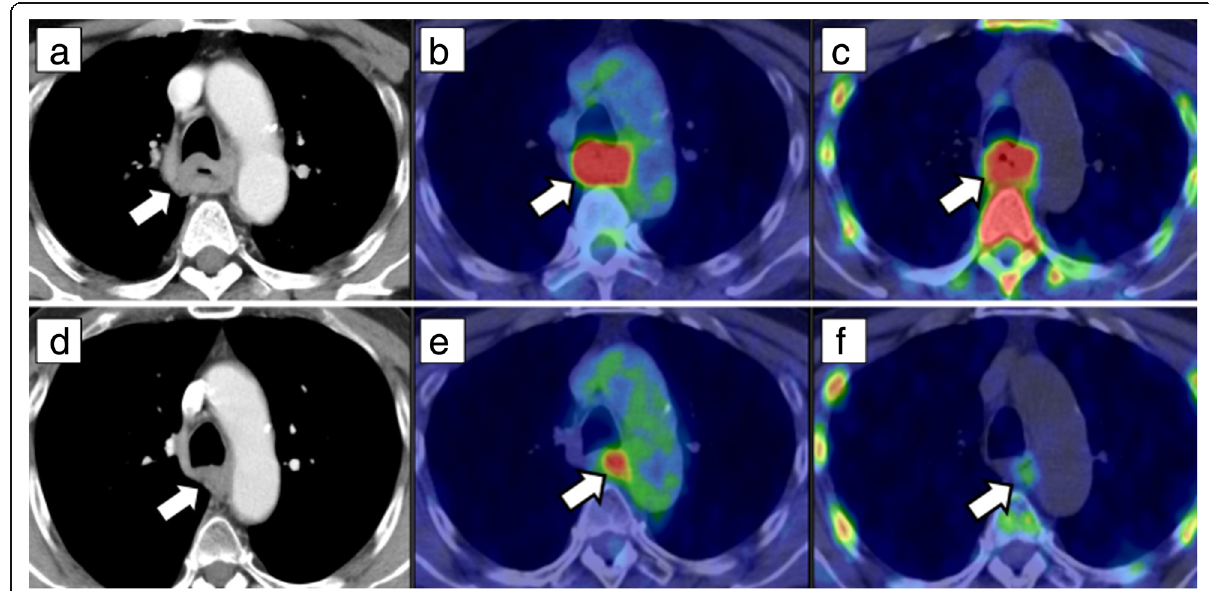
Fig. 3 A 68-year-old man with esophageal cancer treated by neoadjuvant chemoradiation therapy followed by esophagectomy. Baseline images (CT ( a ), FDG-PET/CT ( b ), and 4DST-PET/CT ( c )). Post-neoadjuvant therapy images (CT ( d ), FDG-PET/CT ( e ), and 4DST-PET/CT ( f )). Baseline chest CT showed esophageal cancer ( a : arrow) in the upper thoracic region, and FDG and 4DST PET/CT demonstrated uptake into the primary lesion ( b , c : arrow). Maximum standardized uptake value (SUVmax) of FDG and 4DST was 13.5 and 6.2, respectively. After neoadjuvant chemoradiation therapy, the tumor showed reduction in size ( d : arrow). Post-therapeutic FDG-PET/CT demonstrated FDG-avid (SUVmax = 5.3) primary lesion ( e : arrow) suggesting the possibility of inadequate response. In contrast, 4DST-PET/CT showed relatively low uptake (SUVmax = 2.5) into the tumor ( f : arrow) indicating this patient was a responder. Subsequently, the patient underwent esophagectomy and pathologically confirmed